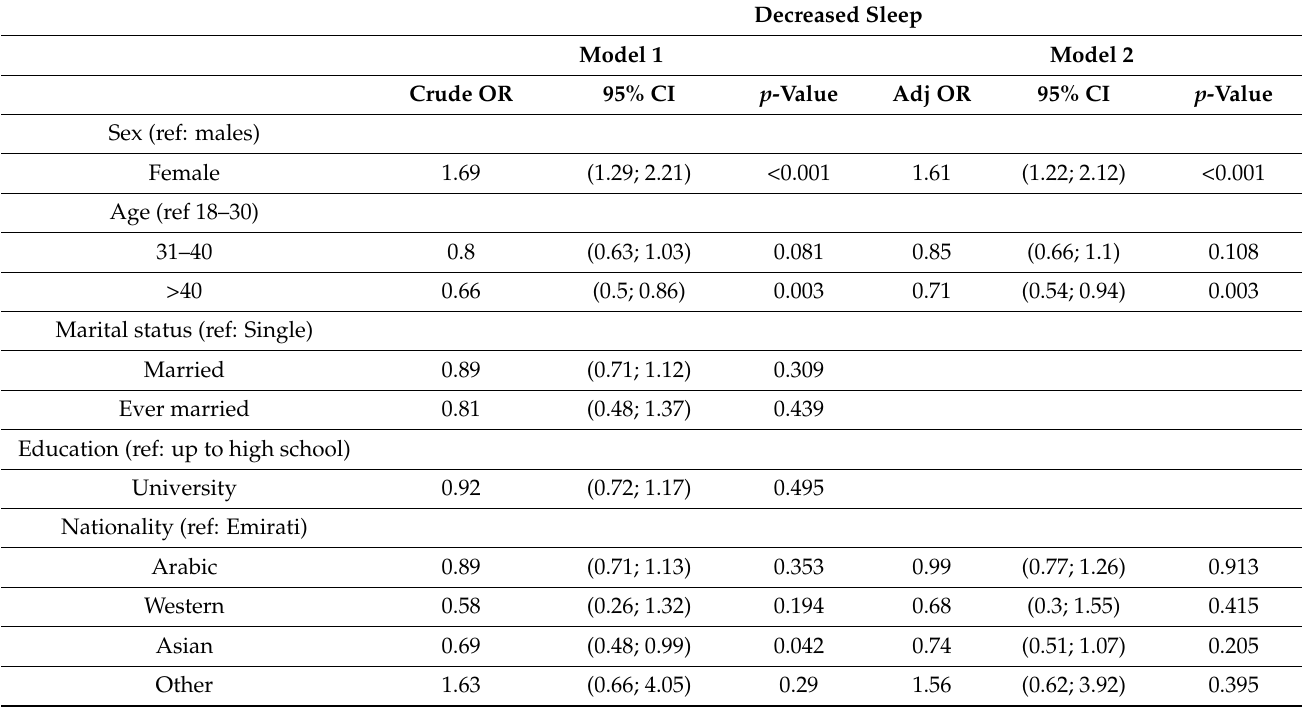
Table A4. Simple and multiple logistic regressions describing the association between decreased sleep and sociodemographic characteristics in the study population ( n =